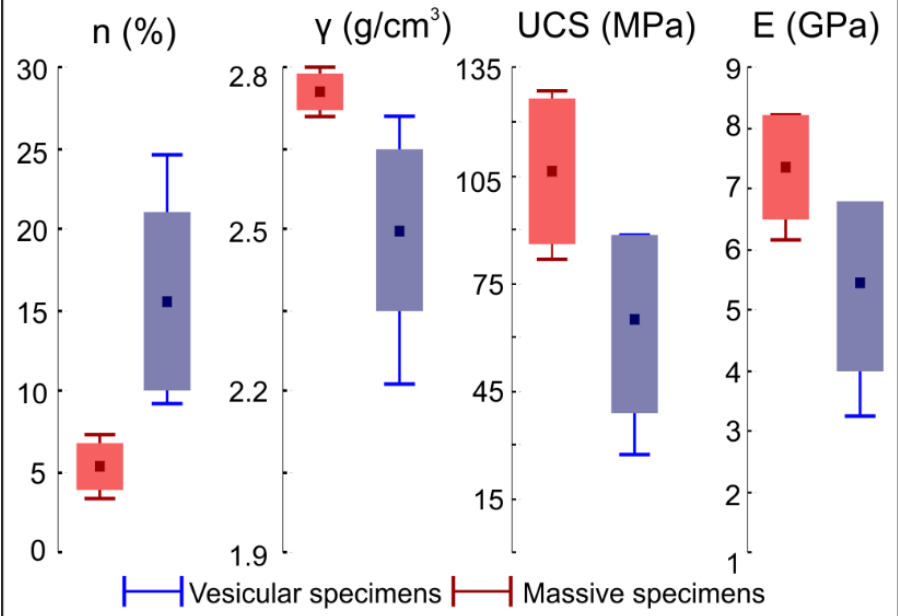
Figure 5. Statistics of the main measured rock physical-mechanical parameters. Boxes indicate standard deviation, whiskers indicate maximum and minimum, and square is for the mean value.